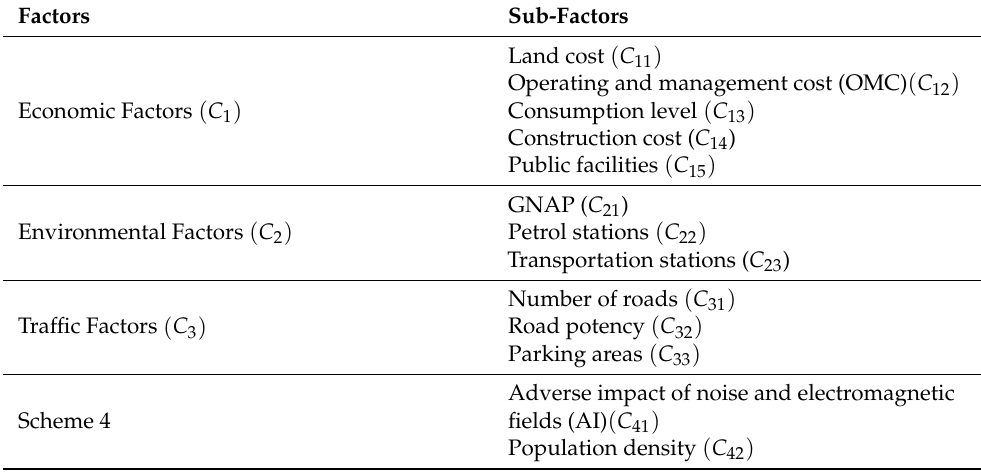
Table 1. Factors and sub-Factors considered in the present study.